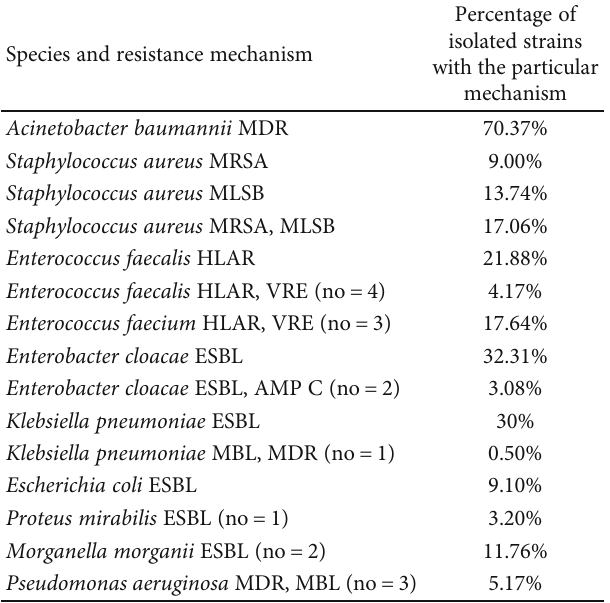
Table 4: Occurrence of particular resistance mechanisms in all analyzed bacterial